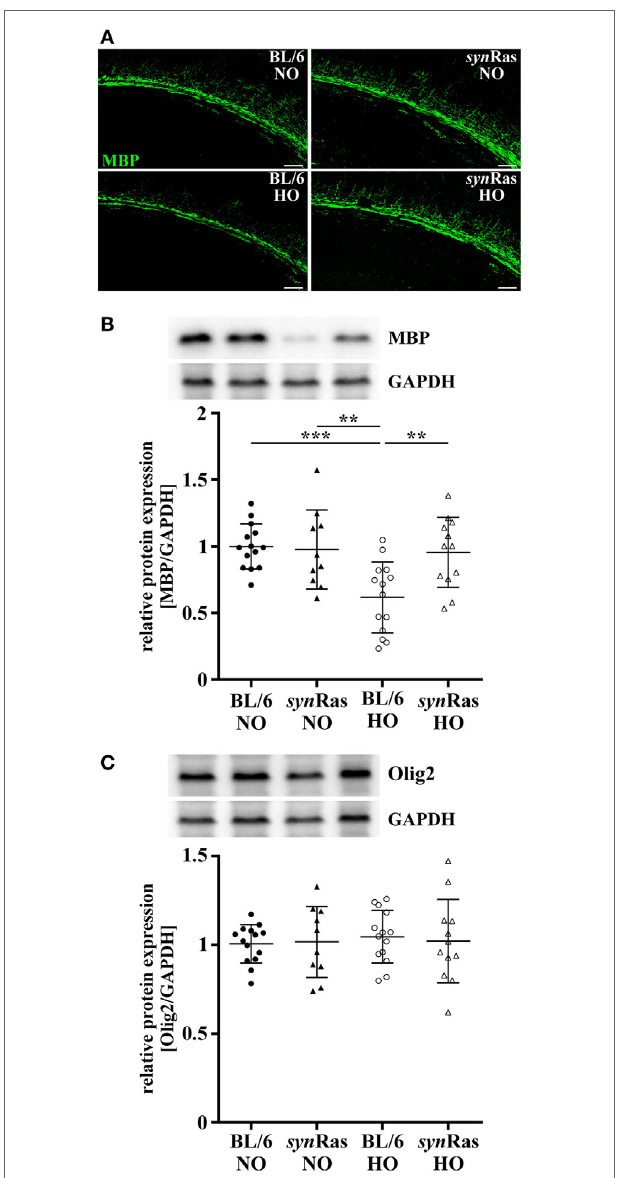
FigUre 3 | Impact of neuronal Ras activation in syn Ras on short-term hyperoxia-induced hypomyelination. Myelin basic protein (MBP) expression was analyzed 4 days post hyperoxia. (a) Representative immunohistochemical staining of the deep cortical white matter assessed by confocal microscopy (scale bar = 100 µm). (B) MBP and (c) Olig2 protein expression was analyzed by Western blot in protein lysates of hemispheres of P11 mice that were exposed to either normoxia [21% oxygen (NO)] or hyperoxia [24 h, 80% oxygen (HO)] at P6 in syn Ras mice or their respective wild-type littermates (BL/6). Data are represented as relative protein expression [MBP/glyceraldehyde 3-phosphate dehydrogenase (GAPDH) and Olig2/GAPDH] normalized to the control group (BL/6 NO) (** p < 0.01 and *** p <